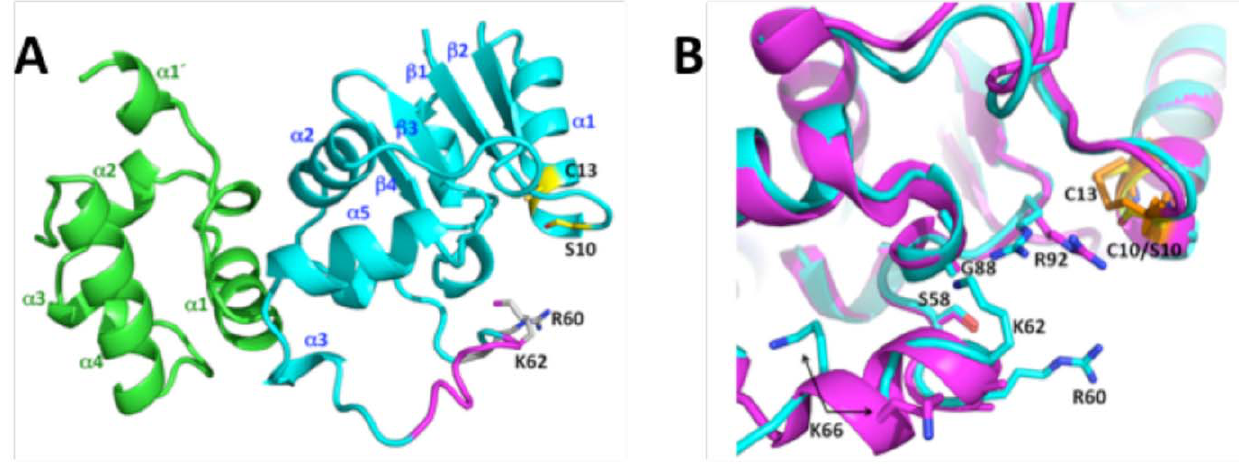
Figure 1. Structure of reduced C10S Spx in complex with a CTD. (A) Spx and a CTD are shown as teal and green ribbons, respectively, and their secondary structures are labelled. Helix a 4, which is observed in oxidized Spx [9] but has unraveled in the reduced form, is colored magenta. The residues mutated in this study, R60 and K62, are labelled and shown as sticks with carbon atoms colored white and nitrogen atoms either blue or magenta. Residues S10 and C13 are labelled and shown as sticks with carbon and sulphur atoms colored yellow and the c -oxygen of S10, red. (B) Close up of the region surrounding helix a 4 and residues C10/S10 and C13 after the superposition of the oxidized and reduced a CTD-Spx complex structures. Reduced Spx is shown as a magenta ribbon and oxidized Spx as a teal ribbon. The C10-C13 disulfide bond is shown in orange sticks and S10 and C13 from the reduced structure are shown as yellow sticks. In the reduced form residue R92 has moved 2.8 A˚ away from its position in the ammonium sulphate-containing oxidized form [9]. The side chain of residue R60 beyond the C b atom is disordered in the sulphate-containing crystal form of oxidized Spx, which was used in the superposition visualized here [9].